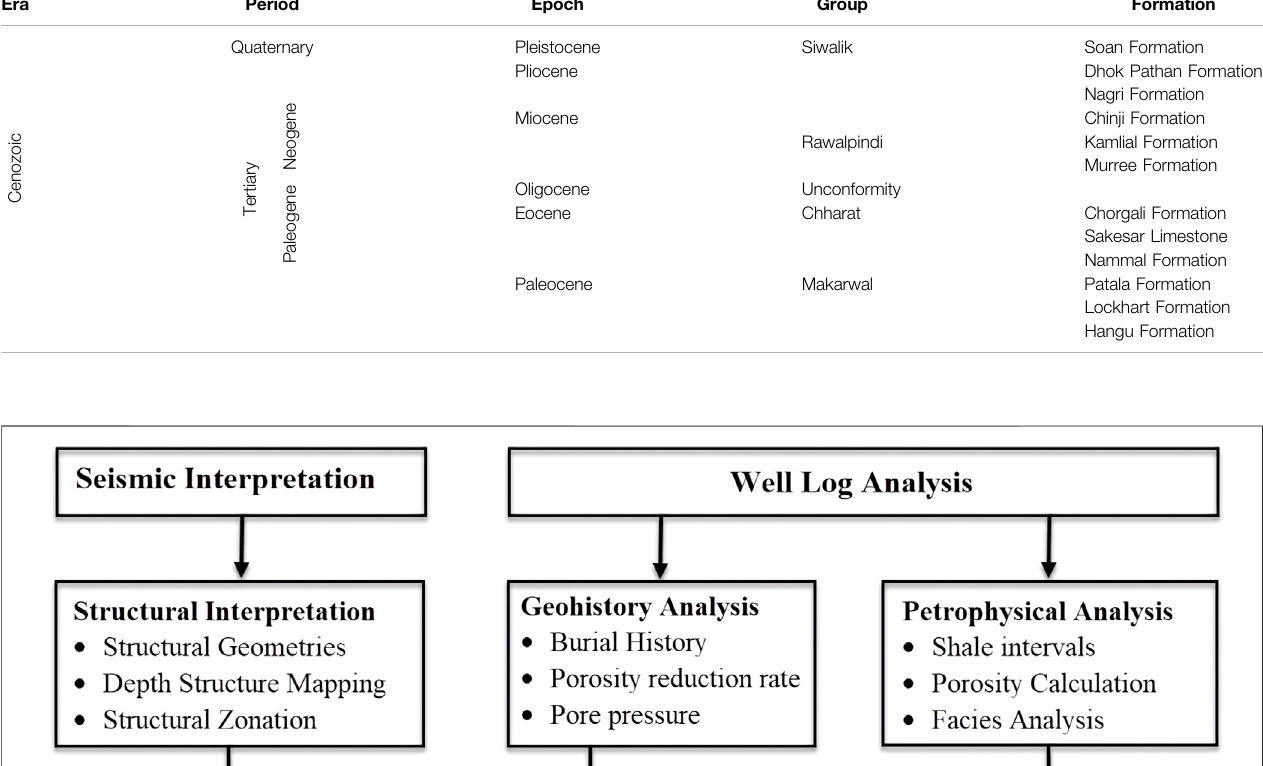
eastern Potwar are evaluated for the pore pressure prediction in Murree Formation. The seismic data includes 2D migrated lines along with navigation data while log data consisted of gamma ray (GR), sonic (DT), resistivity (RES), and density (RHOB) curves.